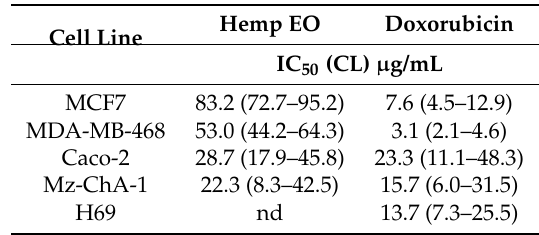
Table 8. Half maximal inhibitory concentration (IC 50 ) values for the cytotoxicity of hemp EO in human cancer cells after 24 h of